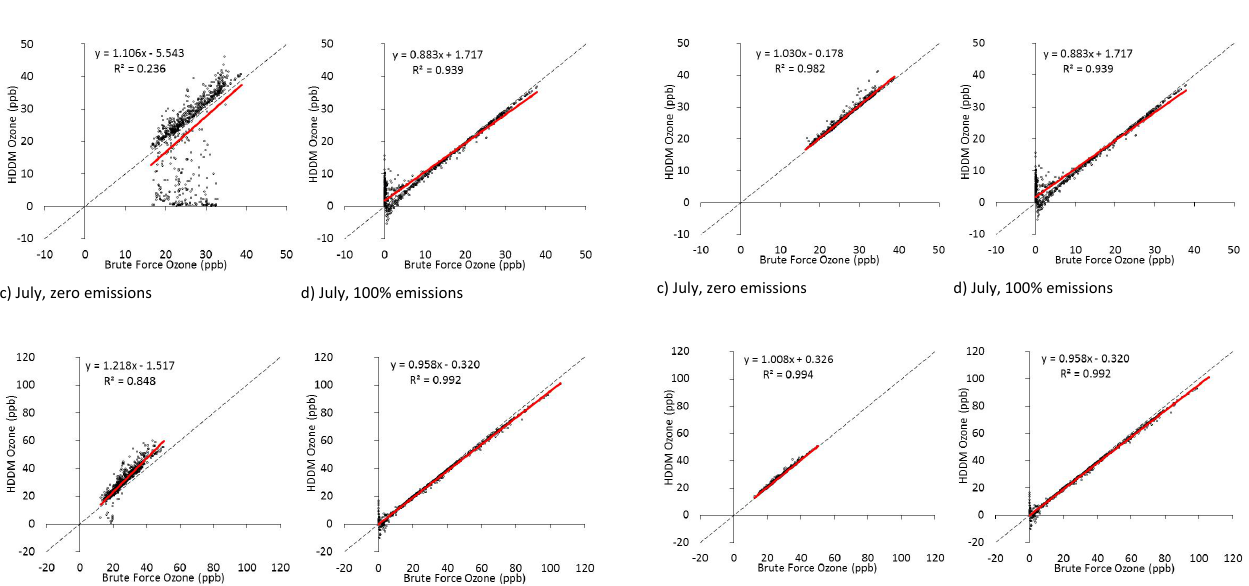
Fig. 5. Hourly ozone at the urban Dallas location predicted by HDDM with Eq. (2) vs. brute force CAMx simulations for (a) zero anthropogenic NO x and VOC emissions in January, (b) 100% an- thropogenic NO x and VOC emissions in January, (c) zero anthro- pogenic NO x and VOC emissions in July, and (d) 100% anthro- pogenic NO x and VOC emissions in July. Dashed lines show 1 : 1 agreement and solid red lines show least-squares regressions.